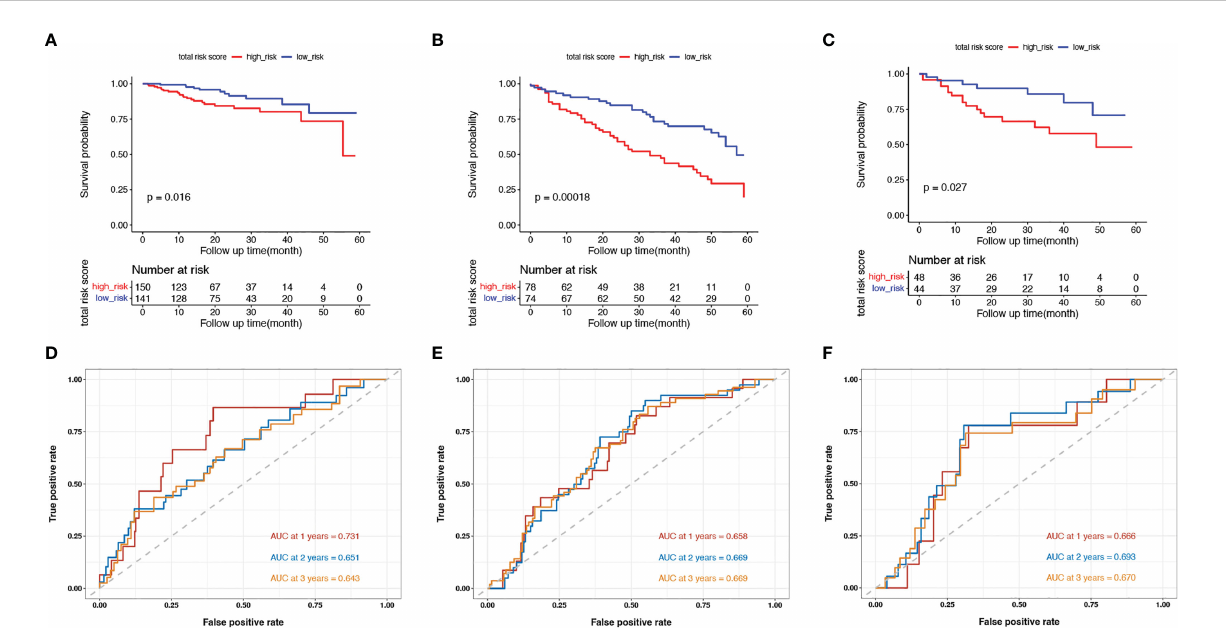
FIGURE 2 Validation of the model in the training cohort and validation cohorts. (A – C) Kaplan-Meier survival curves of in senescent low- and high-risk patients in the TCGA training cohort (A) , the GSE17536 and GSE17537 validation cohort (B) and the GSE38832 validation cohort (C) ; (D – F) The ROC curves